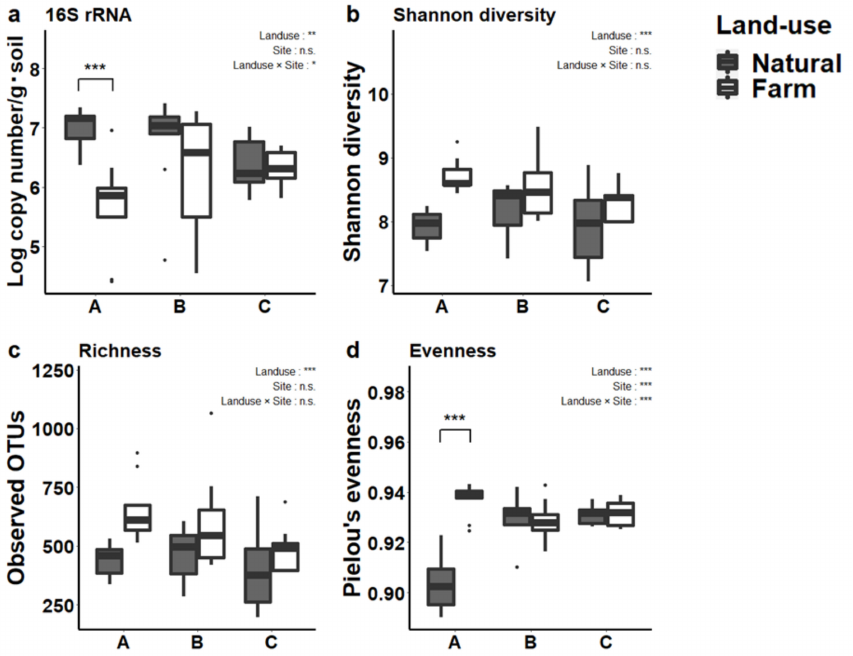
Figure 2. Prokaryotic abundance and diversity. The data were analyzed with two-way ANOVA: ( a ) 16S rRNA gene abundance; ( b ) Shannon diversity index; ( c ) Number of observed OTUs; ( d ) Pielou’s evenness. When there was an interaction between the land-uses and the sites, significant differences between the two land-use types within each site are shown with p -values as *, ** or ***, representing p < 0.05, p < 0.01, or p < 0.001, respectively. The upper/lower whisker indicates the hinge to the highest/lowest value that is within 1.5 times the interquartile range (IQR) of the hinge, where the IQR is the distance between the first and third quartiles. Points outside the IQR are shown as